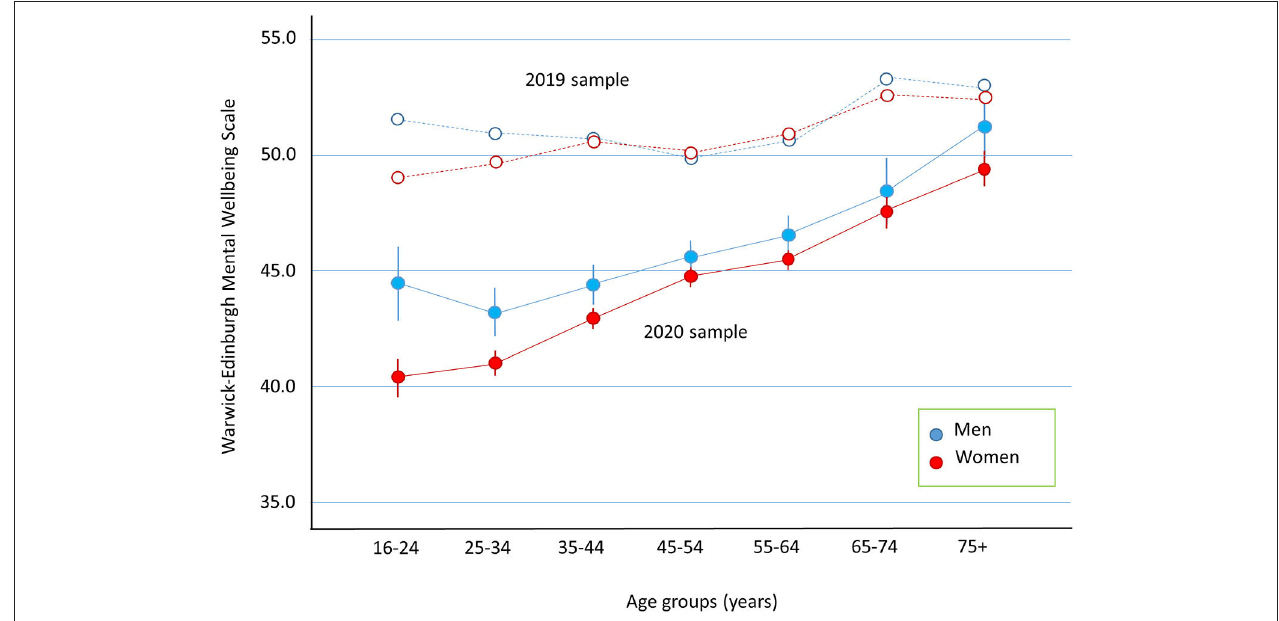
FIGURE 1 | Well-being (WEMWBS) is plotted as a function of age split into 10 year age groups. Error bars represent 95% confidence intervals. Closed symbols are for the 2020 sample and data from the 2019 sample are plotted as open symbols.